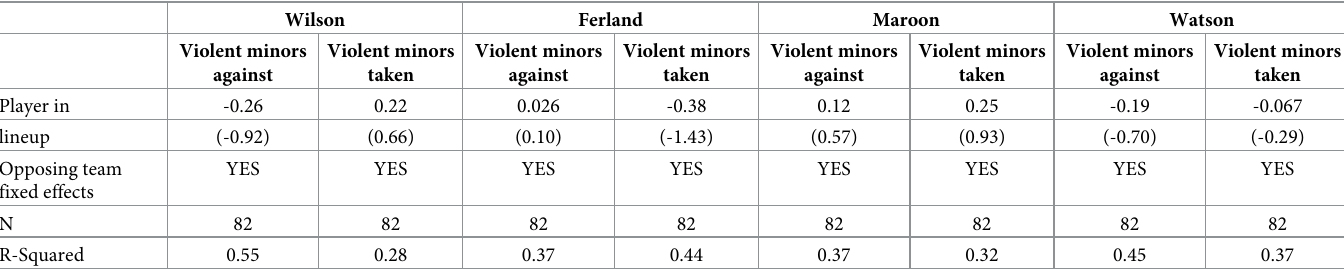
Table 6. Player specific effects on violent minors against and taken. Wilson